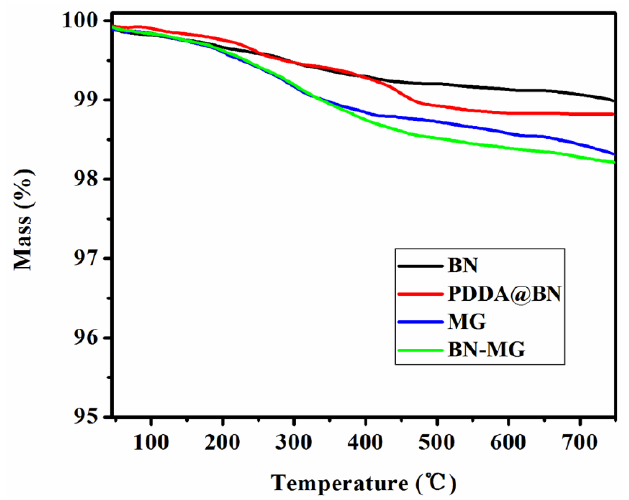
Figure 7. TGA curves for BN, PDDA@BN, MG, and BN − MG.